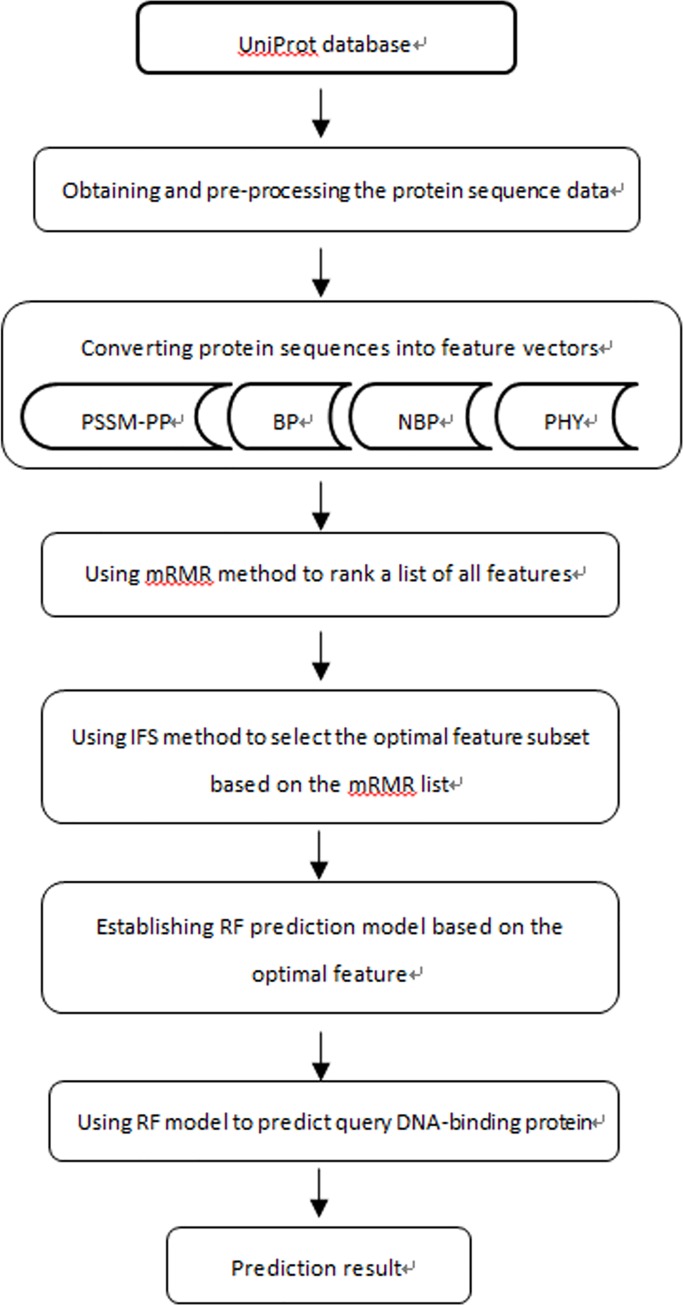
Workflow of DNABP